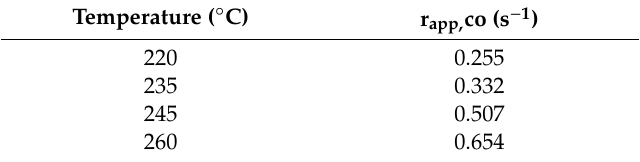
Table 5. Apparent reaction rate normalized per Pt site (r app, co) on the H 2 chemisorption basis.